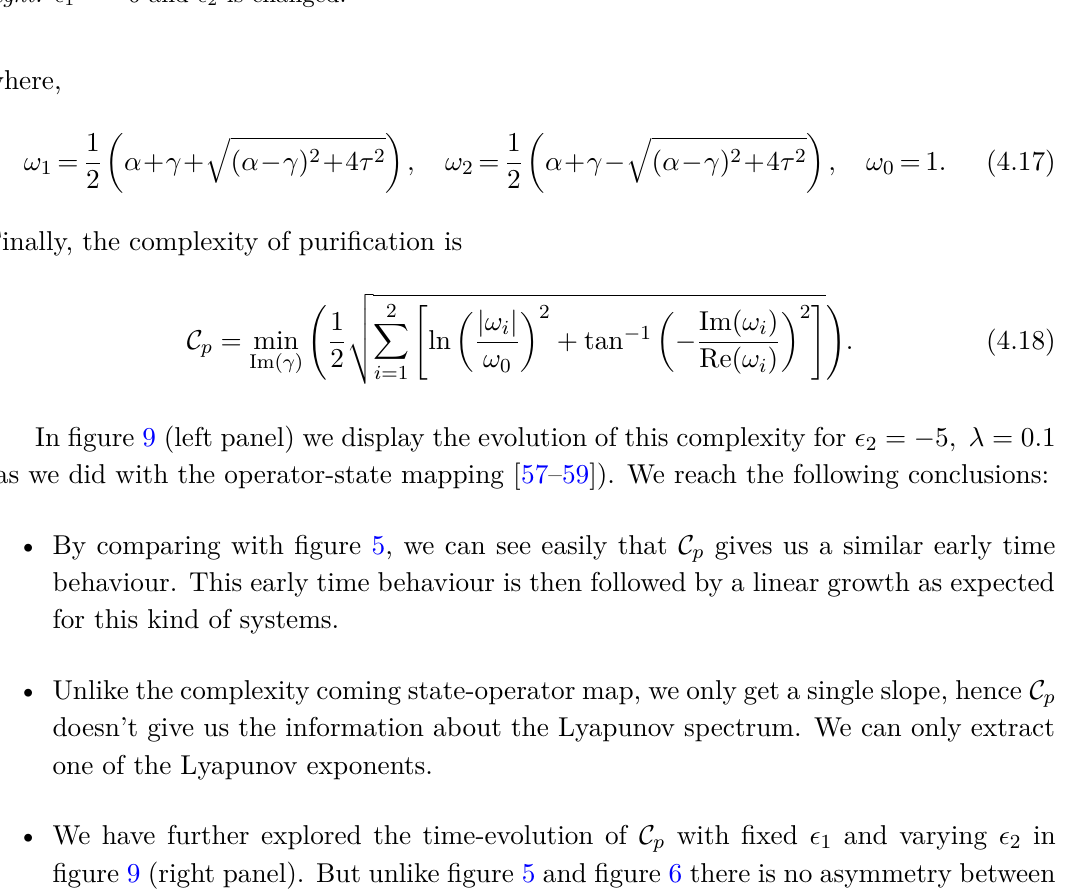
Figure 9 . Evolution of Complexity of purification for λ = 0 . 1 , left: (cid:15) 2 = − 5 and (cid:15) 1 is changed, right: (cid:15) 1 = − 6 and (cid:15) 2 is